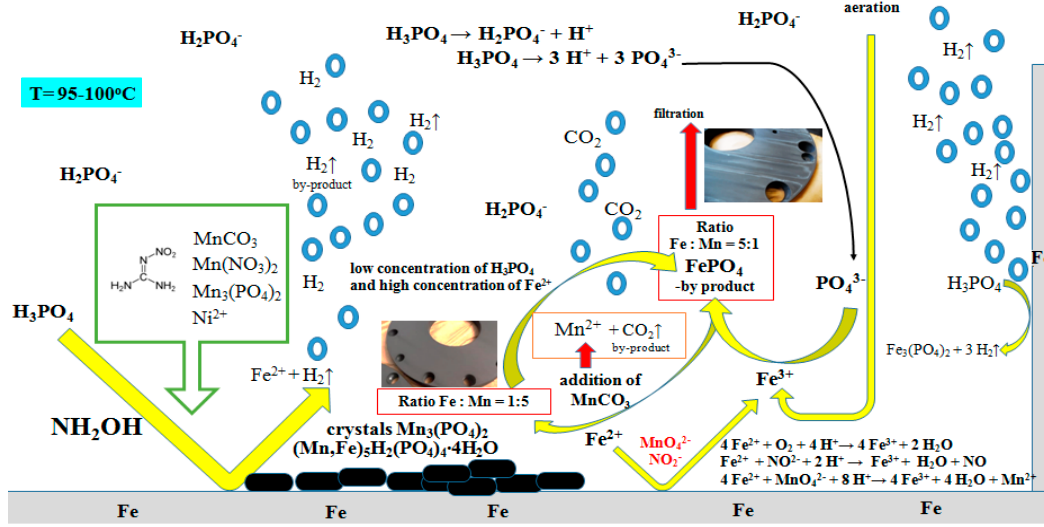
Figure 1. A suggested and simplified mechanism of the manganese phosphating process.